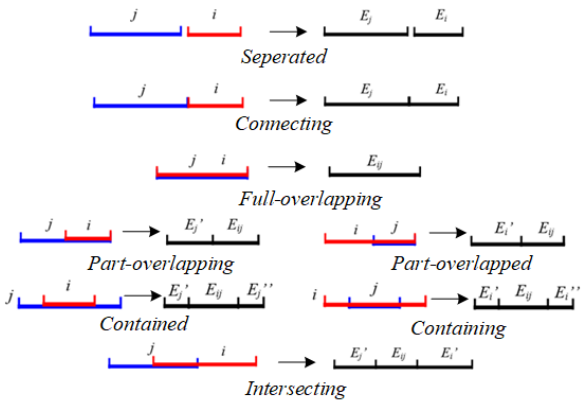
Figure 4. Extraction of edges based on 1D topological